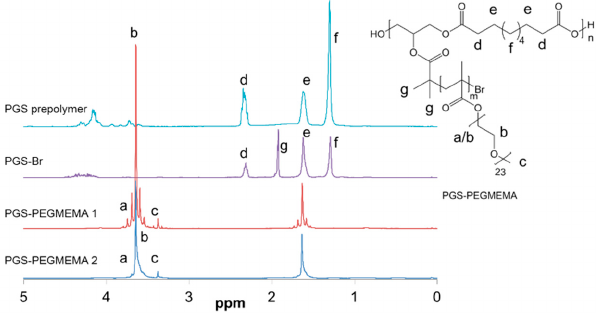
Figure 1. NMR spectrums showing the structures and purity of all intermediates and end products of the synthesis of PGS-PEGMEMA.